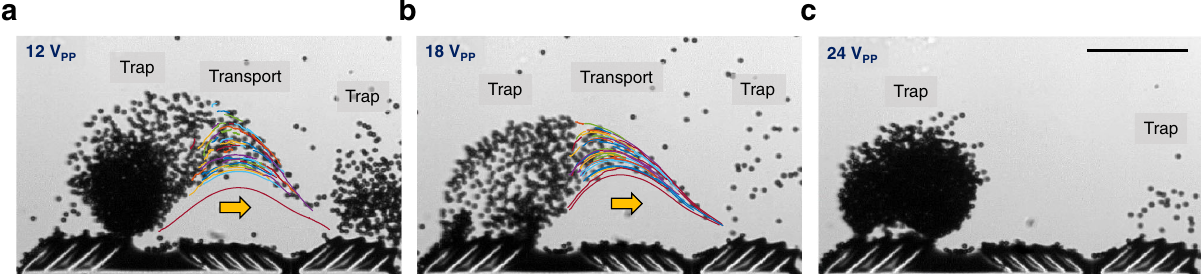
Fig. 6 Acoustic power-dependent transport and trapping. Transport and trapping of 10 µ m particles (colored trajectories) with maximum transport ef fi ciencies of microparticles traveling from + to – ciliary band were achieved at a 12 and b 18 volts peak-to-peak (V PP ). c The trapping mode became dominant as excitation (Supplementary Software 4). Scale bar, 200 μ